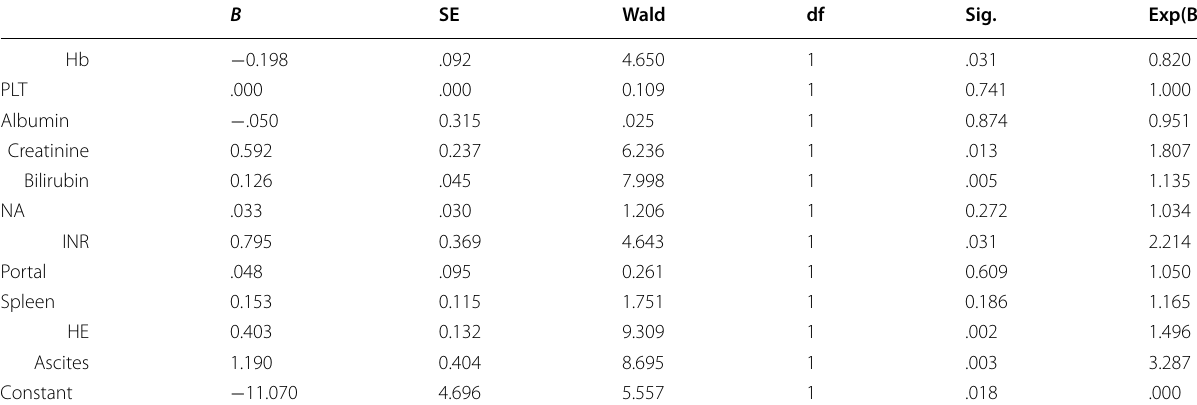
Table 6 New score (CHIBA score) proposed